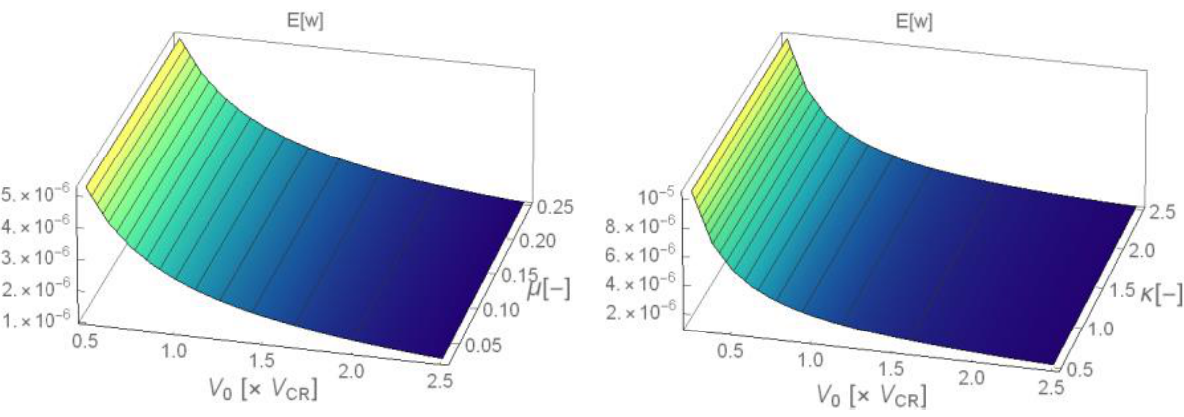
Figure 8: The expected value of deflections in the midspan for different vehicle velocities and also for (a) different parameters μ of the absorbers and (b) different parameters κ of the absorbers.